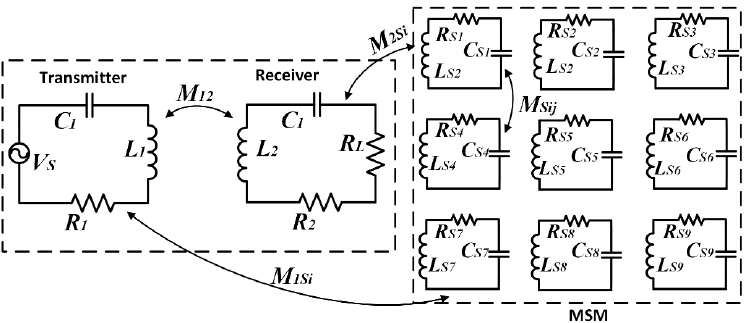
Figure 2. Circuit model of the 3 × 3 matrix shielding metamaterial(MSM) array Wireless power transfer (WPT) system.